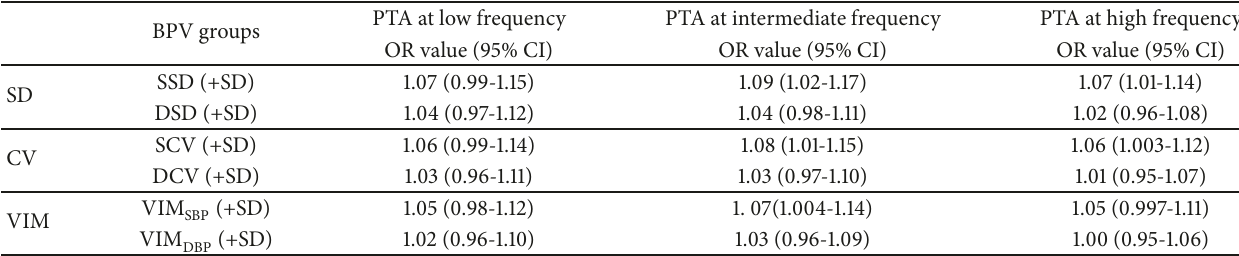
Table 4: Multivariate logistic regression analysis between BPV and hearing